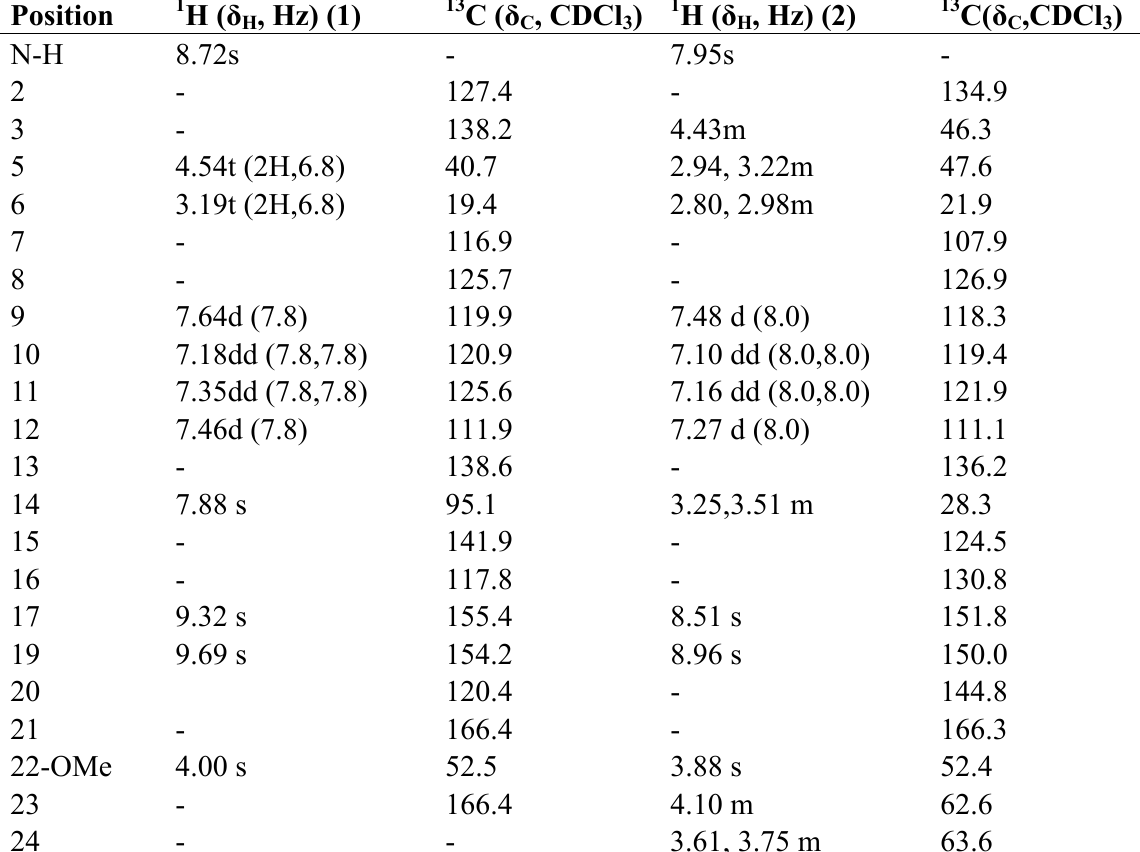
Table 1. 1 H-NMR (400 Hz) and 13 C-NMR (100 Hz) spectral data of neonaucline ( 1 ) and cadamine ( 2 ) in CDCl . 3